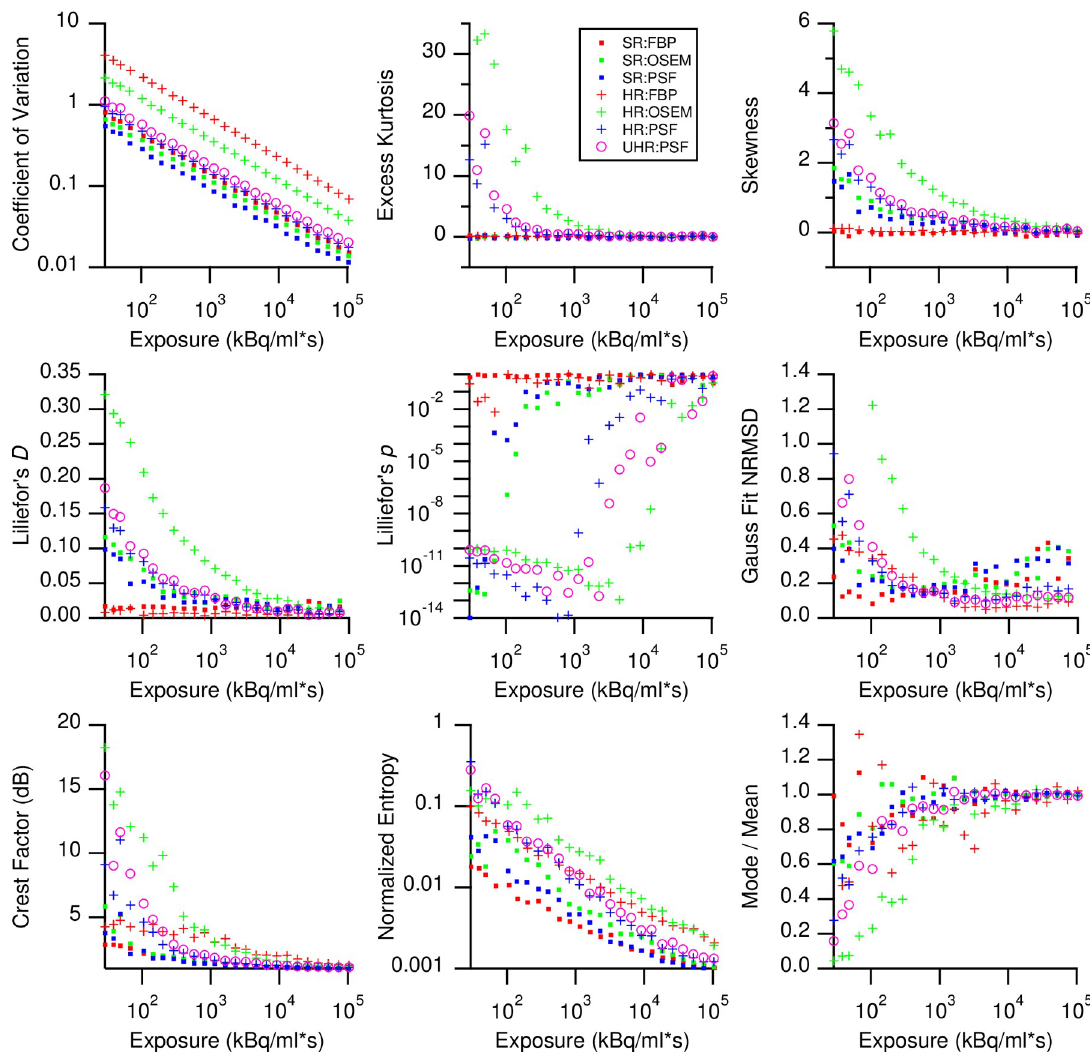
Fig 2. First order statistics of image noise measurements as a function of exposure and grouped according to different reconstruction protocols. After greyscale mapping, the shape of GLCMs remained, but only GLCMs from FBP had a constant μ , Mode , and σ . In OSEM and PSF reconstructions, these values showed a sigmoid x x x function (Fig 4). Comparing Figs 2 and 3 suggests that greyscale mapping produced GLCMs of similar extension with regard to the grey scale count, because only using values occurring inside the VOI. Especially in the case of FBP, this led to GLCMs with a Gaussian cross-section of similar extent, while PSF based reconstructions still had GLCMs of varying shape and extent. Mapping the GLCMs in greyscale units maintained the general shape of the matrices, but revealed how μ , Mode , and σ moved towards higher values with increasing exposure in x x x OSEM and PSF reconstructions, while remaining constant in FBP reconstructions (Fig 4).